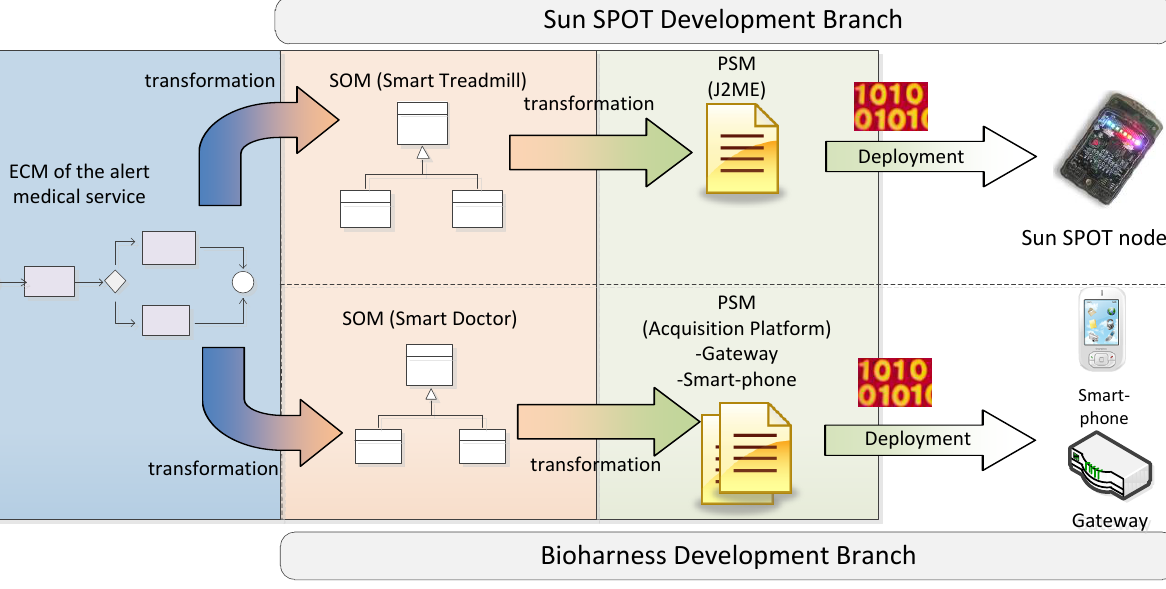
Figure 15. Development branches for the two cases considered following the ROOD